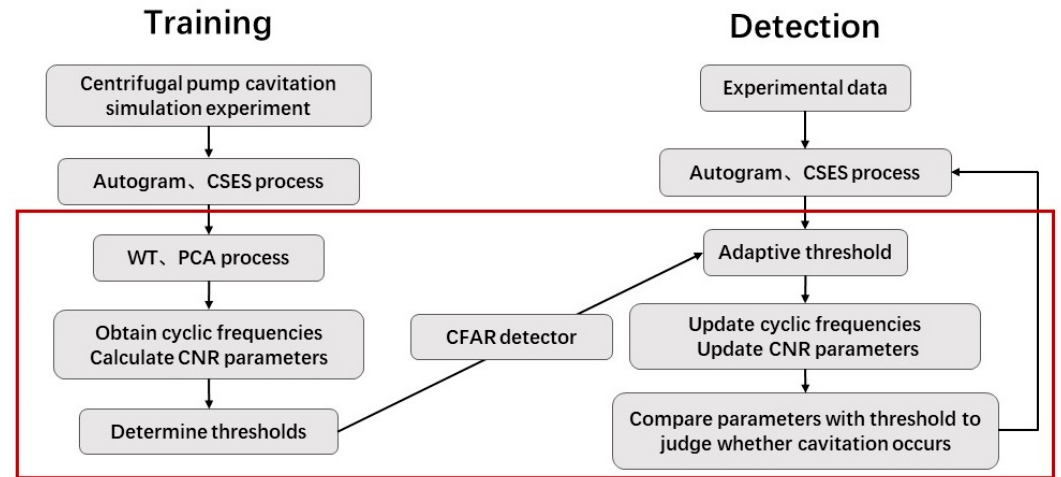
Figure 4. Sensors 2020 , 20 , x FOR PEER REVIEW